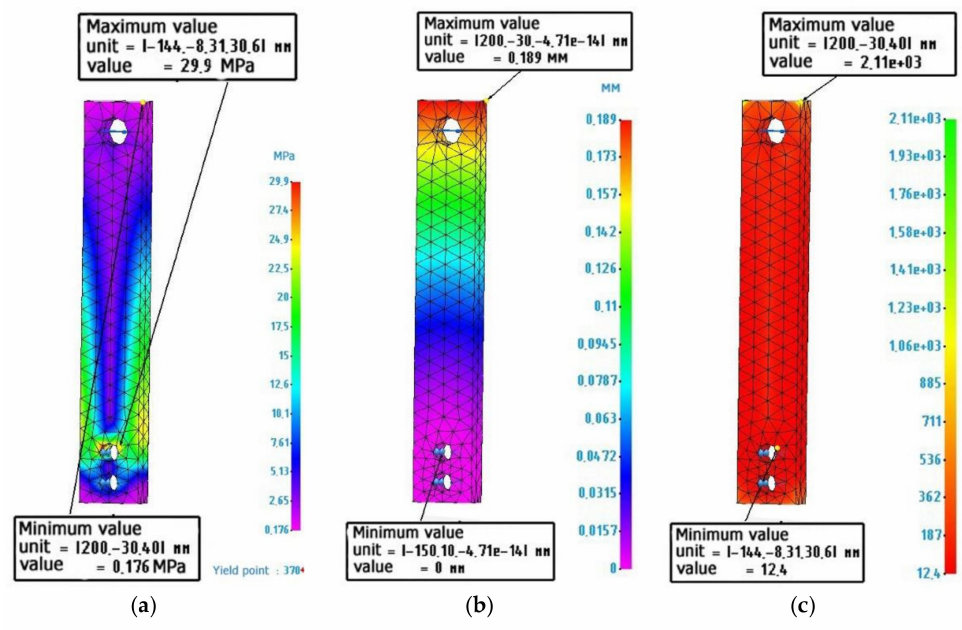
Figure 6. Finite element analysis of a metal sample: ( a ) Stress diagram according to von Mises, maximum value 29.9 MPa; ( b ) Strain diagram, maximum value 0.189 mm: ( c ) Safety factor diagram, minimum value